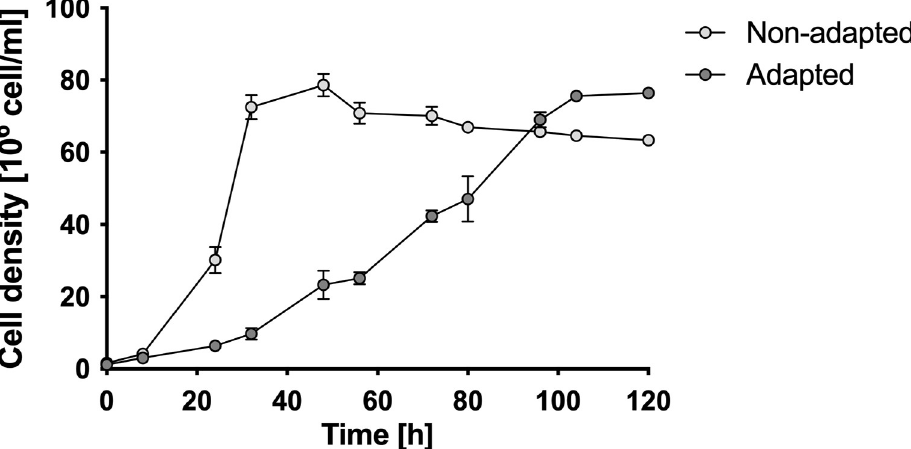
Fig 1. Growth of L . ferriphilum DSM 14647. Curves represent the growth of adapted and exposed to 180 mM NaCl (grey circles), and non-adapted and non-exposed (white circles) cell cultures. Data represent the average of 3 independent experiments. Error bars represent standard deviation. Initial cell density, 1x10 6 cells mL -1